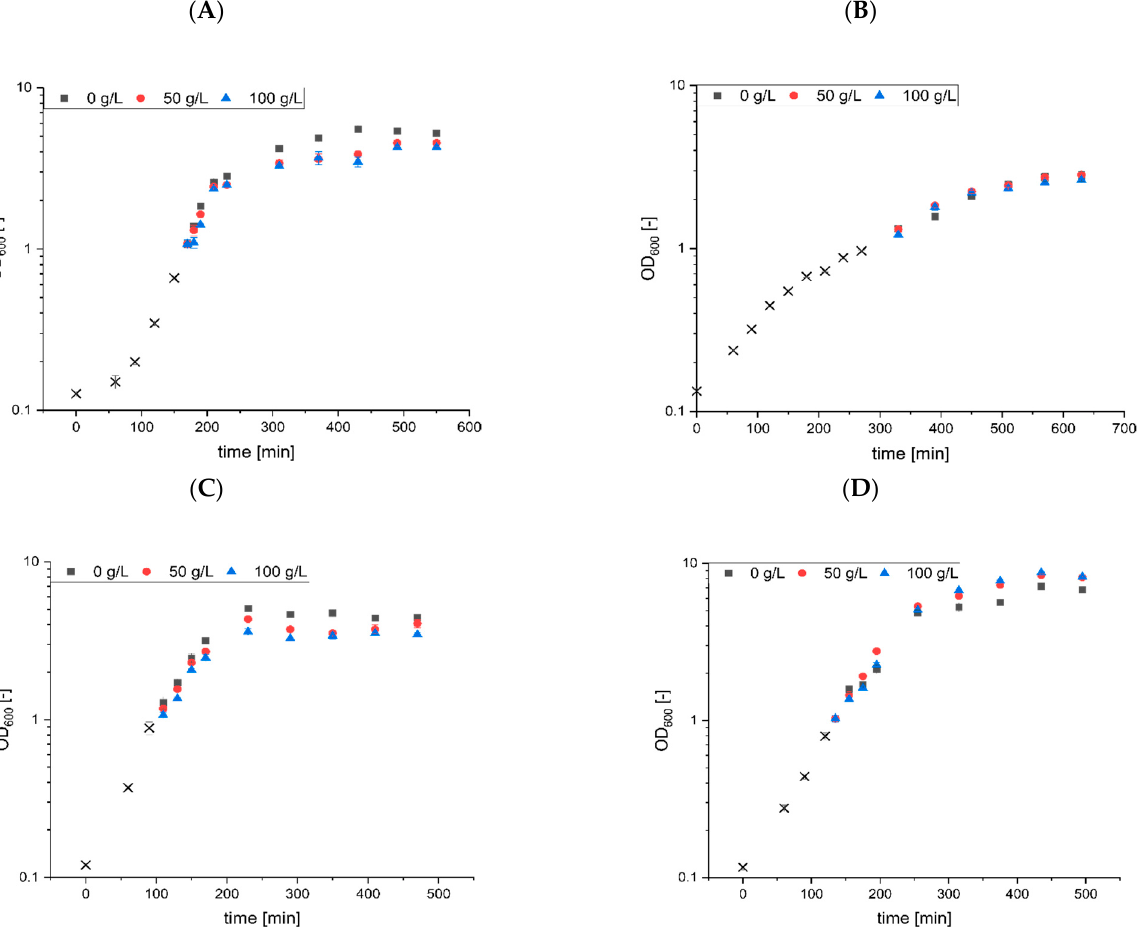
Figure 1. Surfactin stress approaches with biotechnologically established strains. Cell growth of B. subtilis KM0 ( A ), C. glutamicum ATCC13032 ( B ), E. coli BL21 (DE3) ( C ) and P. putida KT2440 ( D ) was monitored in LB medium. When the cultures reached an OD600 of approximately 1 (black crosses), equal volumes of cell culture were mixed with increasing concentrations of surfactin: 0 g/L (black squares), 50 g/L (red dots) and 100 g/L (blue triangles). Cell growth was monitored for further 6 h after stress induction. All stress approaches were performed in biological